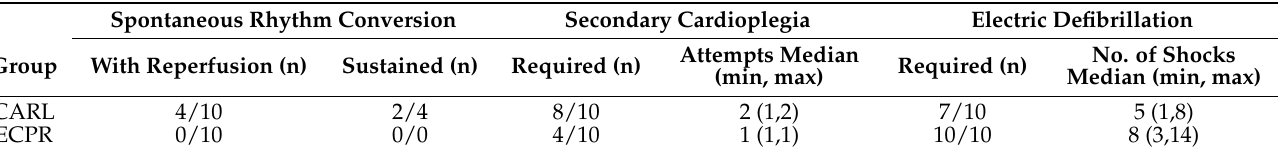
Table 3. Rhythm conversation procedure.